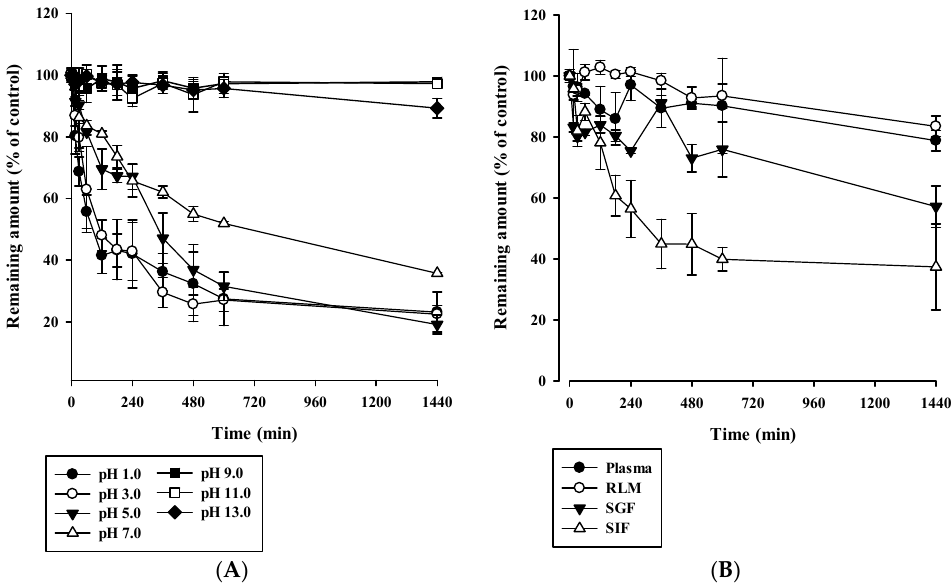
Figure 2. Stability profiles of acacetin in phosphate buffers of various pHs ( A ) and plasma, rat liver microsomes (RLM), SGF, and SIF ( B ). The bullet symbols and error bars represent the means and standard deviations, respectively ( n = 3).